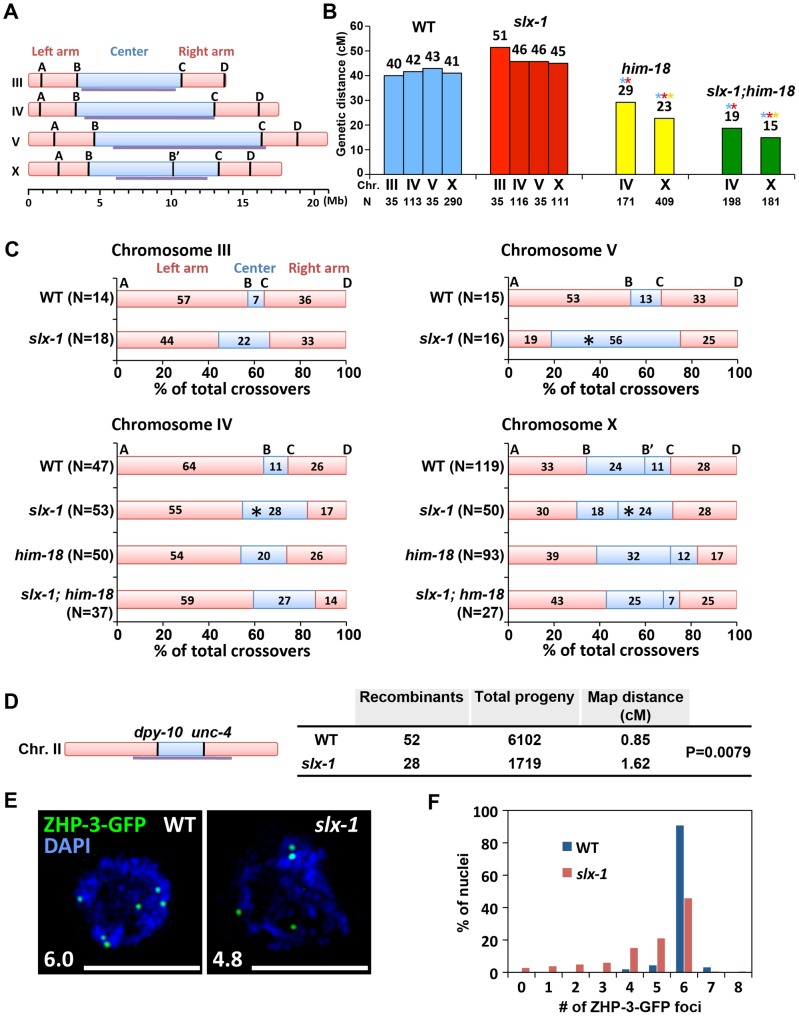
SLX-1 promotes the regulation of crossover distribution but not crossover frequency.(A) Schematic representation of chromosome domains. Four SNP markers for chromosome III, IV and V and five SNP markers for the X chromosome are shown as A, B, B', C and D. The intervals A–B, B–C and C–D indicate portions of the left arm, center, and right arm, respectively. Purple lines indicate the central domain on which crossover frequency is lower compared to the arms defined by Rockman and Kruglyak [79]. (B) Analysis of crossover frequencies on chromosomes III, IV, V and X in wild type, slx-1, him-18 and slx-1;him-18 mutants. Crossover frequencies are measured between SNP positions A to D. N = number of crossprogeny scored. (C) Analysis of crossover distribution on chromosomes III, IV, V and X on the indicated genotypes. The positions on the chromosomes indicated as left, center and right correspond to intervals A–B, B–C and C–D, respectively as indicated on panel A. Asterisks indicate significant differences compared to wild type. (D) Crossover frequency of wild type and slx-1 mutants between dpy-10 and unc-4 loci on center region of chromosome III. (E) Representative images of ZHP-3-GFP foci in late pachytene nuclei (zone 7) in wild type and slx-1 mutants. The average number of ZHP-3-GFP foci is shown at the bottom left. Bars, 5 µm. (F) Quantitation of ZHP-3-GFP foci in late pachytene nuclei in wild type and slx-1 mutants.